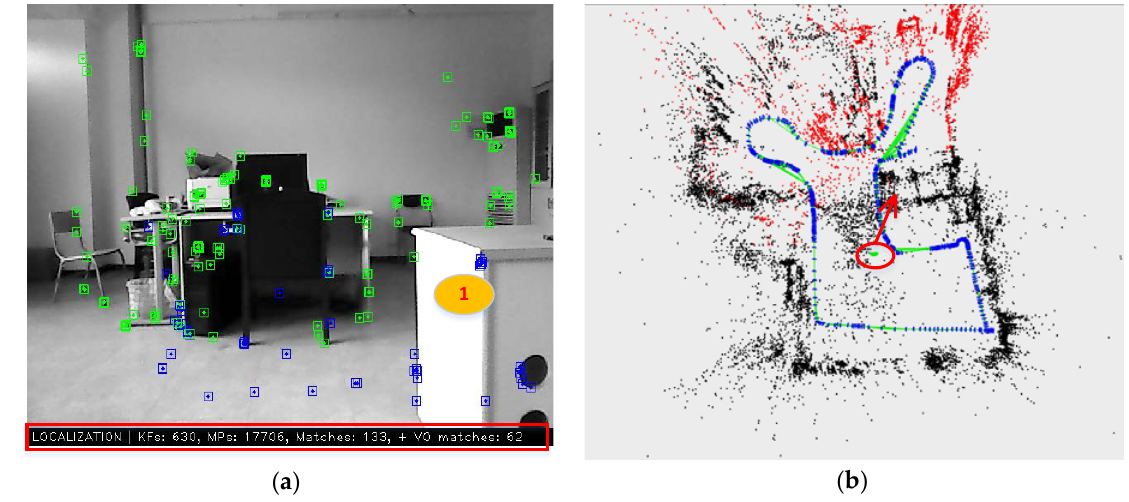
Figure 8. Real-time running status after a system restart. ( a ) Current RGB frame and data of system; ( b ) real-time status of map and tracking.